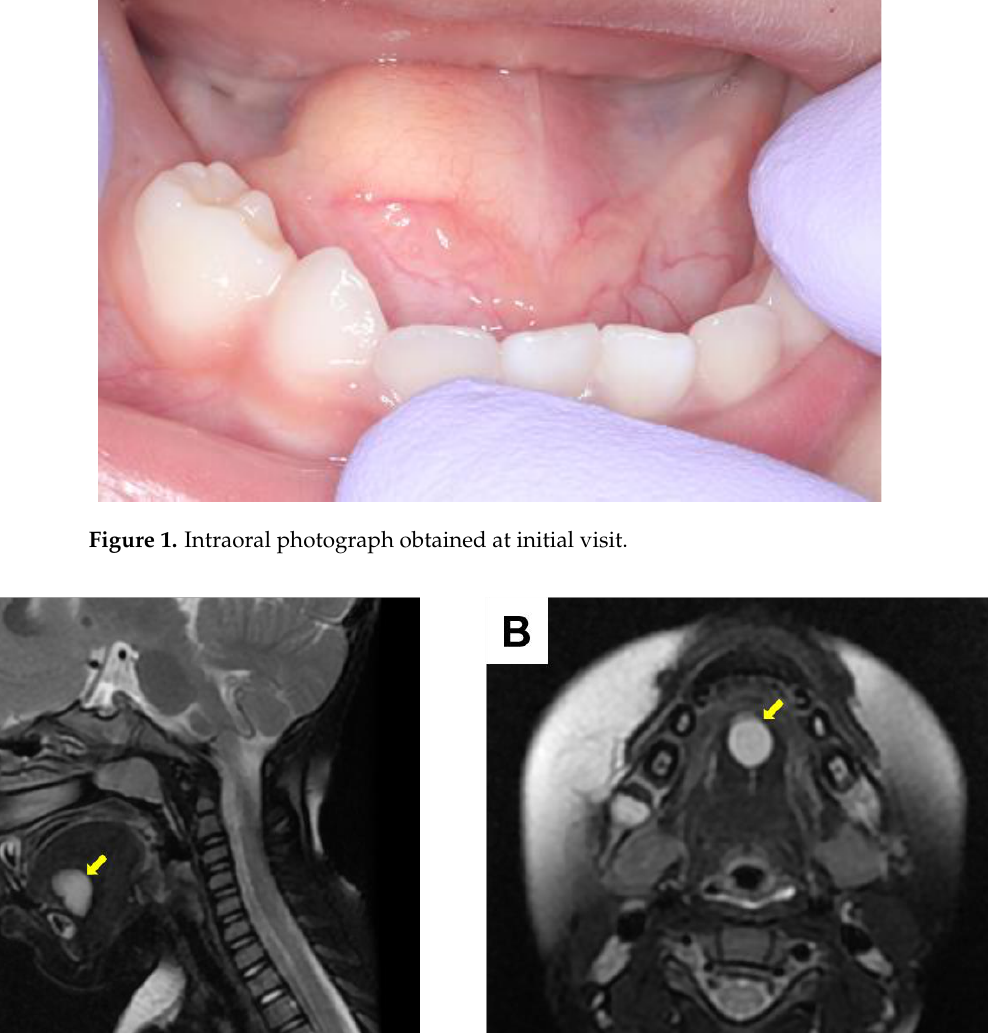
Figure 3. Intraoperative appearance. ( A ) Before operation. ( B ) Lesion appearance after incision. ( C ) After removal. ( D ) After suturing.